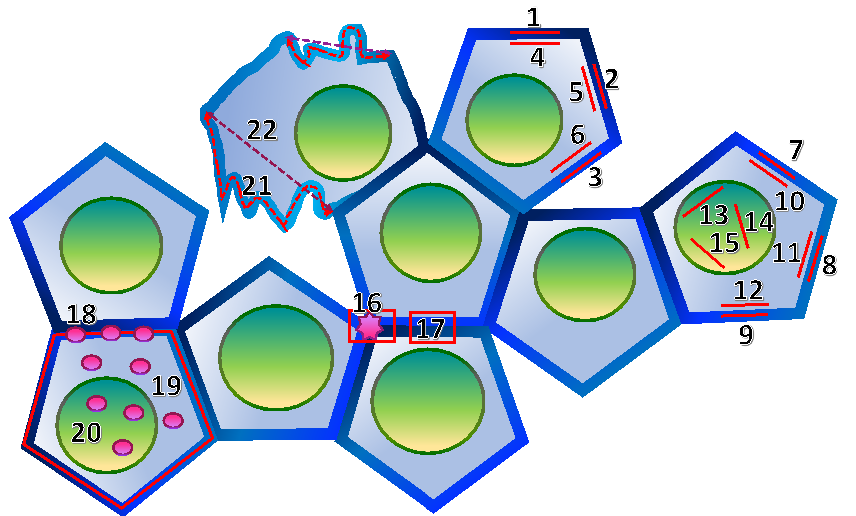
Figure 1. Schematic outlining the quantification strategy for evaluating junctional/cytoplasmic localization ratios of PLEKHA7, AGO2 (lines 1–6); junctional/(cytoplasmic + nuclear) localization ratio of DROSHA (lines 7–15); tricellular vs. bicellular fluorescence intensities (boxes 16,17); proximity ligation (PLA) junctional (18) vs. cytoplasmic (19) and nuclear (20) signals; and linear vs. wriggled junctional lengths (lines 21–22). Star indicates a tri-cellular junction. See text, Section 2.5, for